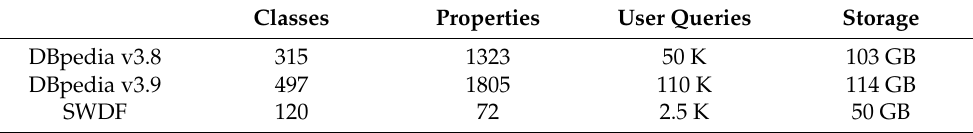
Table 5. Characteristics of the KGs used for experimental evaluation.